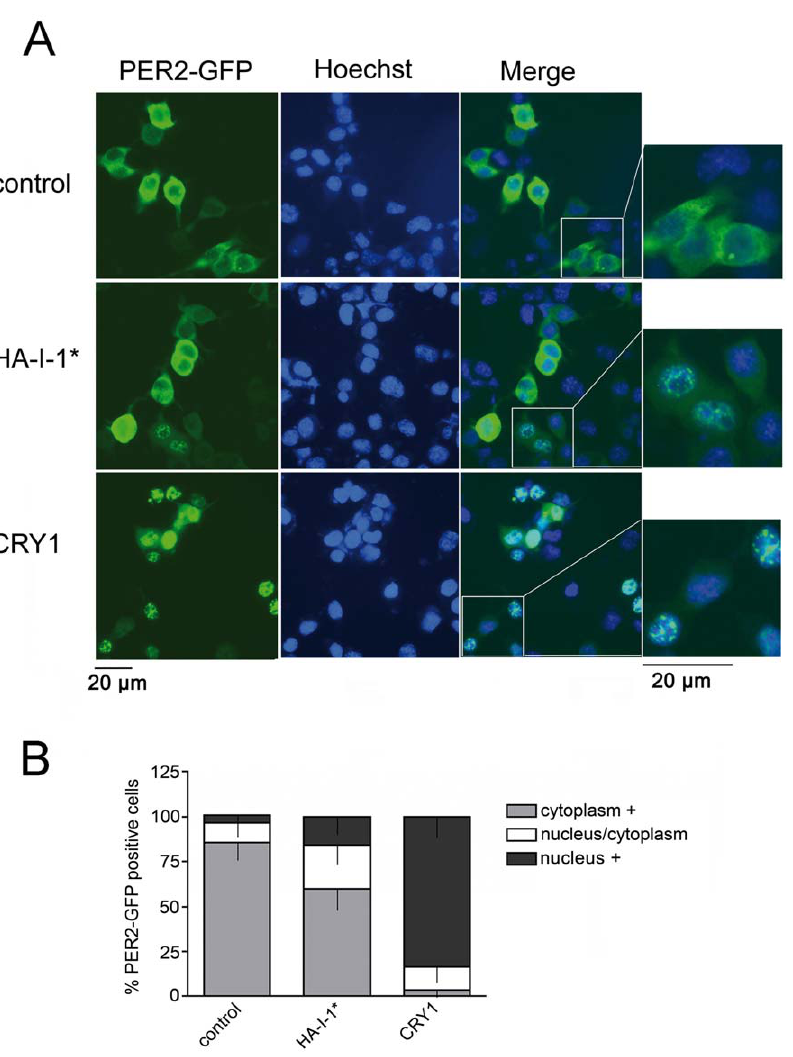
Figure 5. Inhibition of PP1 in cells modulates PER2 subcellular localization. (A) NG108-15 cells were transfected with PER2-GFP together with either empty expression vector (control, upper panels), expression vector for HA-tagged I-1* (HA-I-1*; middle panels), or CRY1 (lower panels). Representative fluorescent microscopic images are shown. From left: EGFP fluorescence (green), Hoechst-stained nuclear fluorescence (blue) and a merge of these images. Scale bar: 20 m m. (B) Quantitative distribution of the subcellular expression of PER2-GFP in NG108-15 cells. Cells were transfected with PER2-GFP together with either empty expression plasmid, expression vector for HA-I-1*, or expression vector coding for CRY1. Cells were assessed for predominantly nuclear, nuclear and cytoplasmic, or predominantly cytoplasmic PER2-GFP expression. Relative distribution was determined blinded in three independent experiments. The distribution was evaluated in at least 80 GFP-positive cells for each experiment. Data are represented as mean +